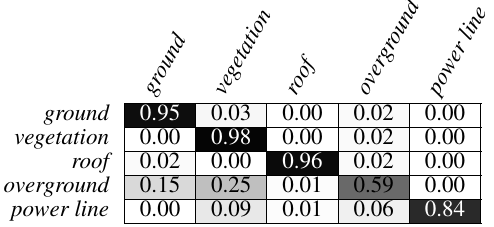
Figure 3. Confusion matrix: each row represents the instances in an actual class, whereas each column represents the instances in a predicted class. Please note that values are normalized so that the sum of every row is equal to